Question: Which kind of chart has been used to present this data?
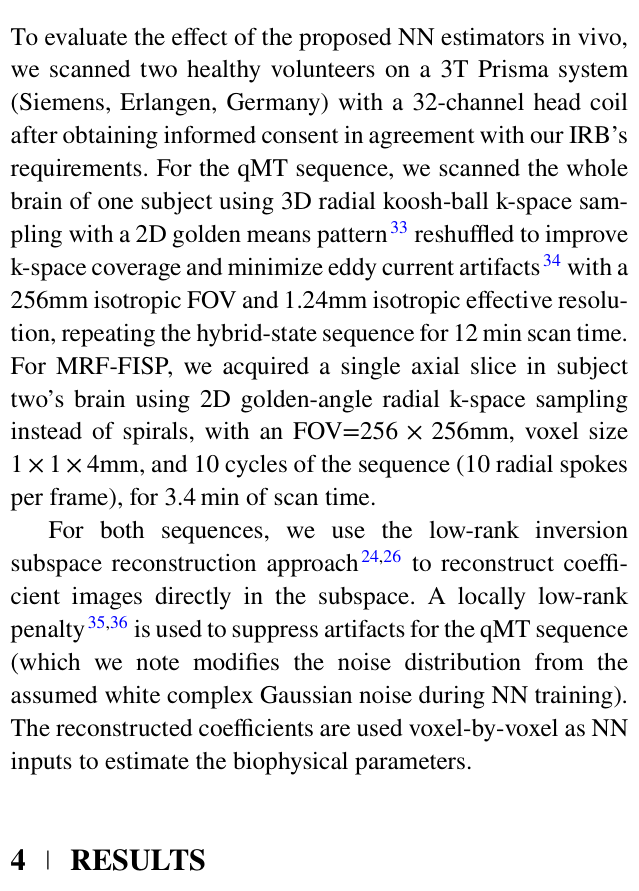
Answer: box